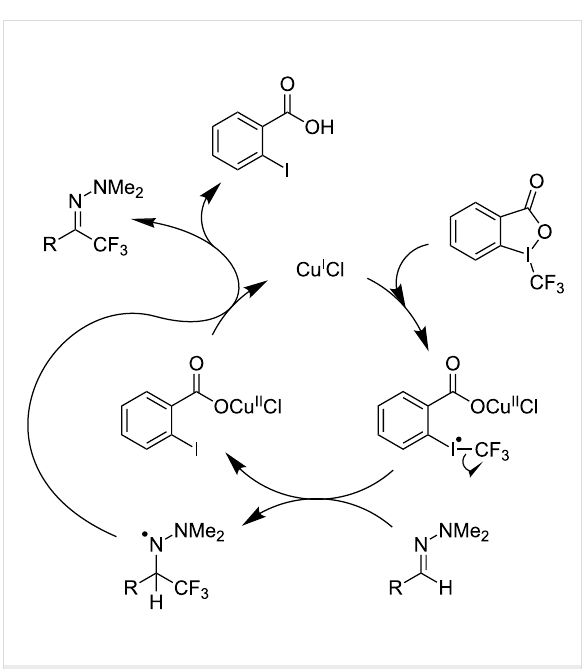
Figure 7: Proposed catalytic cycle for the copper-catalyzed trifluoro- methylation of N , N -disubstituted (hetero)arylhydrazones by D. Bouyssi, O. Baudoin et al.